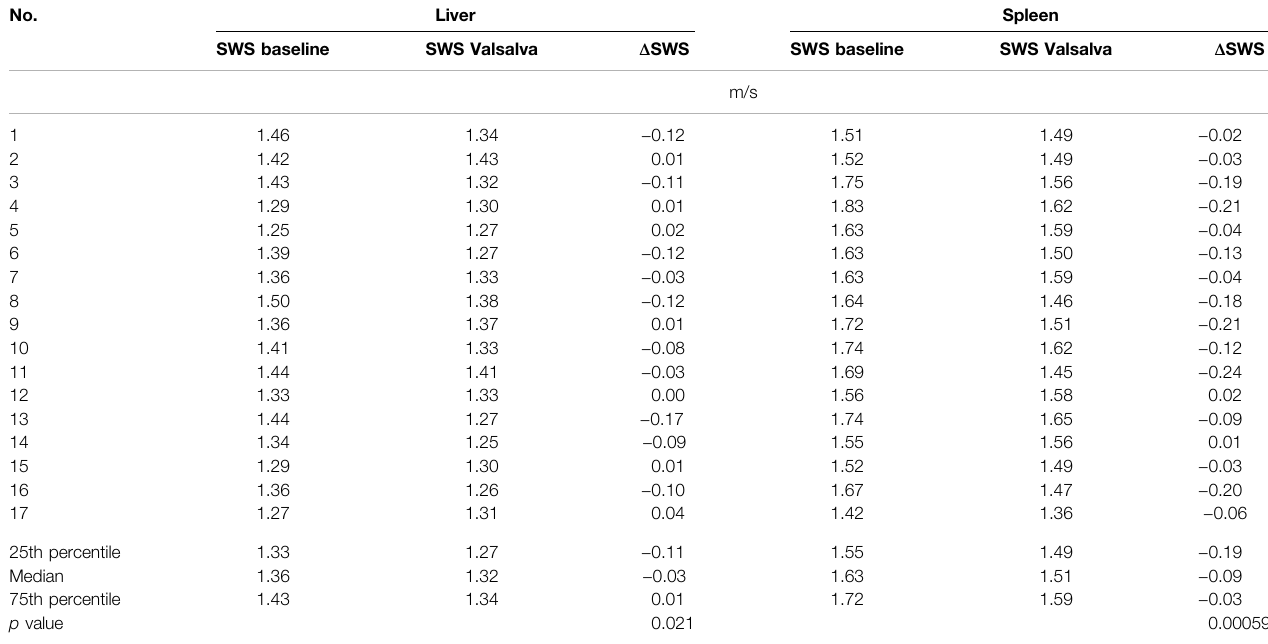
TABLE 2 | Individual and group median values, group 25th and 75th percentiles, and group p values of liver and spleen shear wave speed (SWS) at baseline and during the Valsalva maneuver. No.